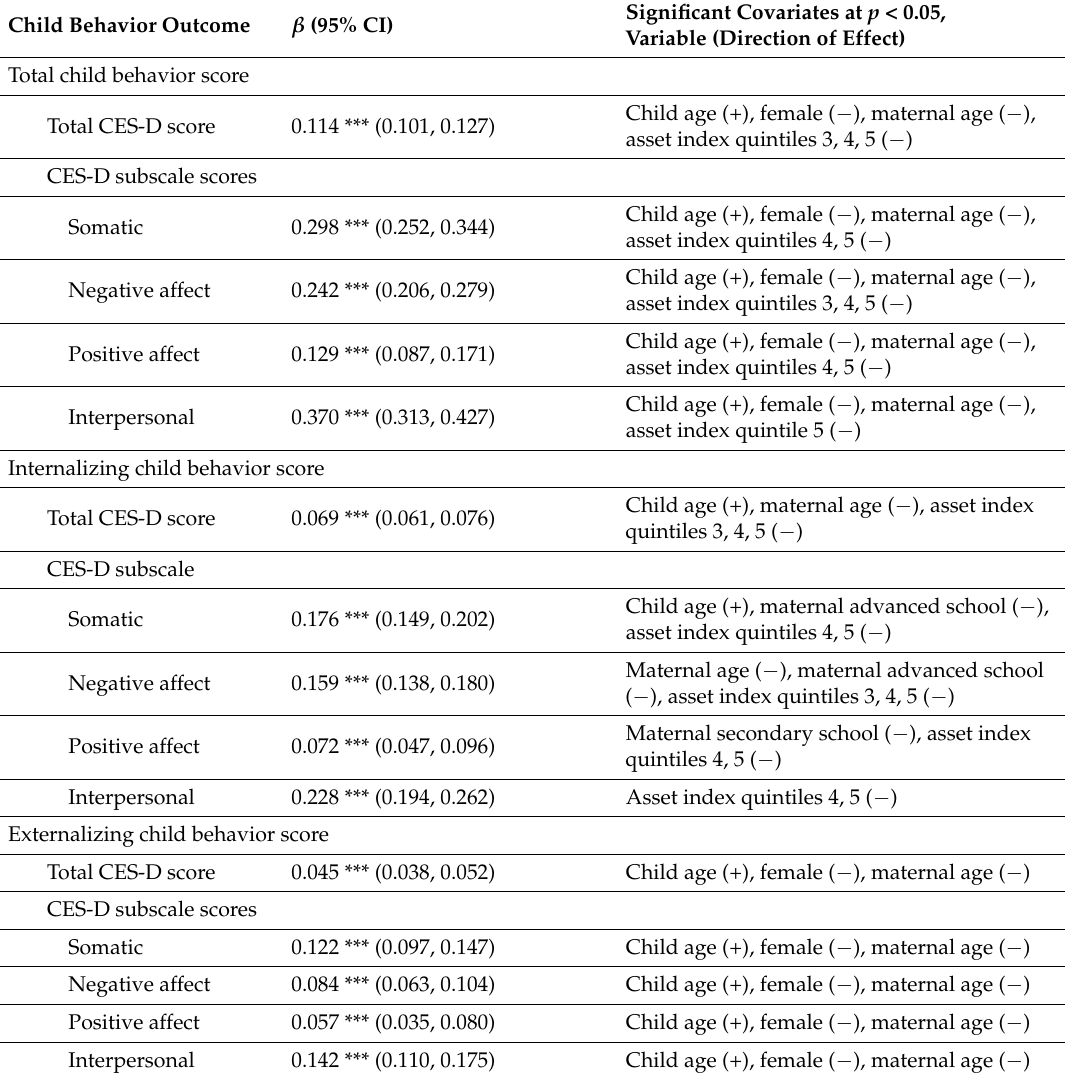
Table 2. Fully adjusted models examining maternal depressive symptoms and child behavior (n = 5503 children, 4442 mothers) a